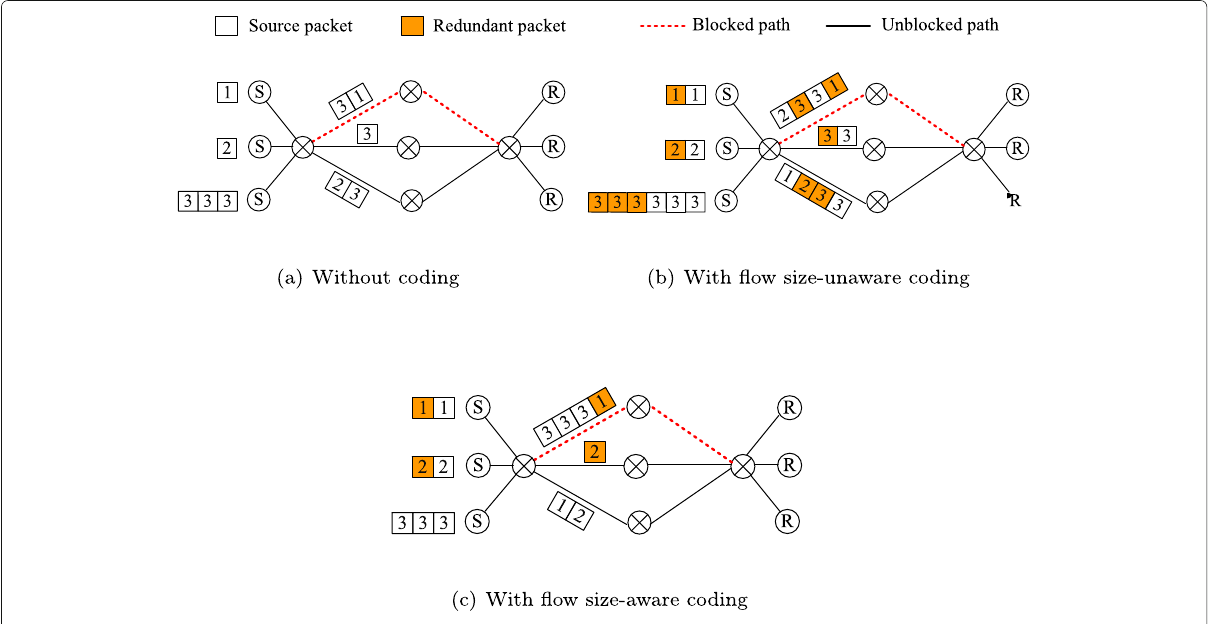
Fig. 1 Three transmission mechanisms. The numbers in the boxes indicate flows’ ID is a representative protocol in this type of transmission mechanism. It implements encoding by performing an XOR operation on all the packet payloads of a congestion window, and adds an encoded data packet for each con- gestion window. Corrective significantly reduces network latency with low computational and bandwidth